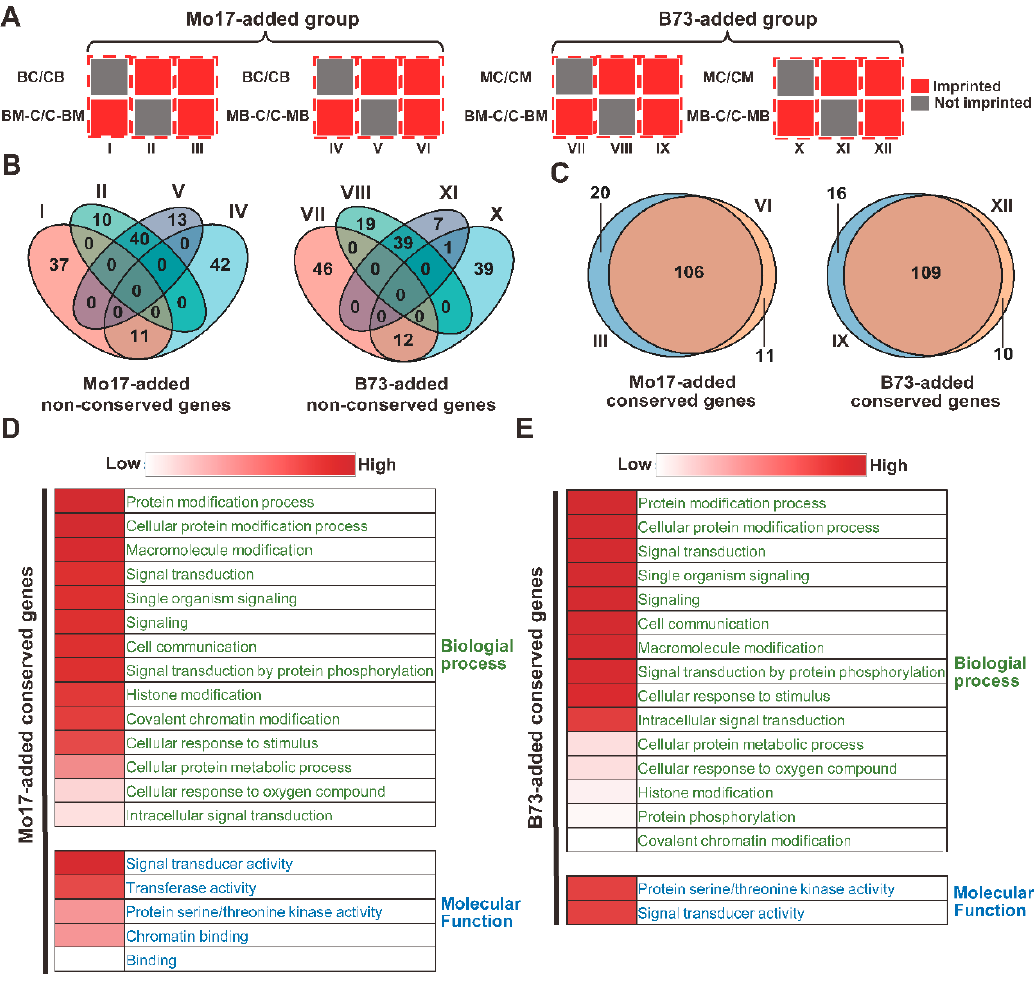
Figure 2. Conservation and GO analysis of the Mo17 ‐ added and B73 ‐ added non ‐ conserved genes. ( A ) Classification of the genes belonging to the B73 ‐ added group and Mo17 ‐ added group. The Mo17 ‐ added group was divided into six sets: I, II, III, IV, V and VI. The B73 ‐ added group was divided into six sets: VII, VIII, IX, X, XI and XII. ( B ) Overlap analysis of the Mo17 ‐ added non ‐ conserved genes and B73 ‐ added non ‐ conserved genes. I, II, IV and V refer to four sets of Mo17 ‐ added groups in Figure 2A. VII, VIII, XI and X refer to the four sets of B73 ‐ added groups in Figure 2A. ( C ) Overlap analysis of the Mo17 ‐ added conserved genes and B73 ‐ added conserved genes. III and VI refer to the two sets of Mo17 ‐ added groups in Figure 2A. IX and XII refer to the two sets of B73 ‐ added groups in Figure 2A. ( D ) GO analysis of the Mo17 ‐ added conserved genes. ( E ) GO analysis of the B73 ‐ added conserved genes.